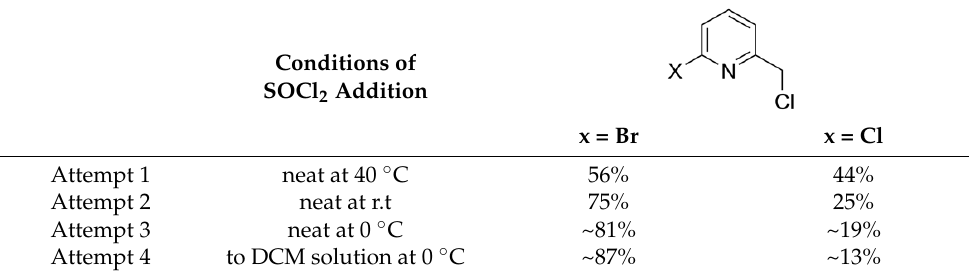
Table 1. Conversion percentages of 2-bromo-6-hydroxymethylpyridine to 2-bromo-6-chloro- methylpyridine (x = Br) and 2-chloro-6-chloromethylpyridine (x = Cl) using SOCl 2 under specified reaction conditions.